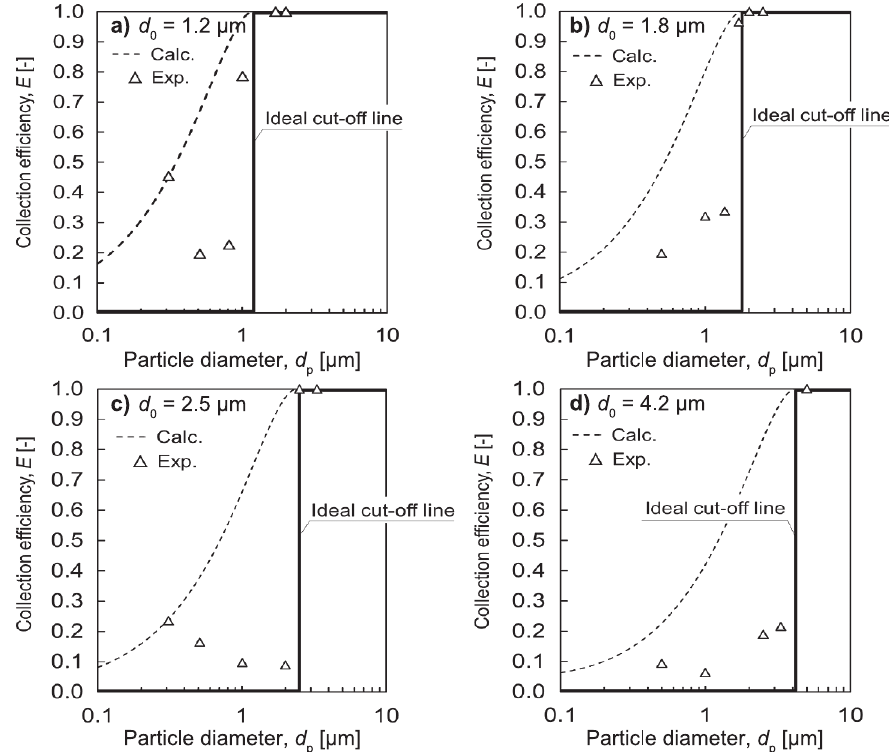
Fig. 8 Separation curve of metal screens with various openings at filtration velocity of 3 m/s.